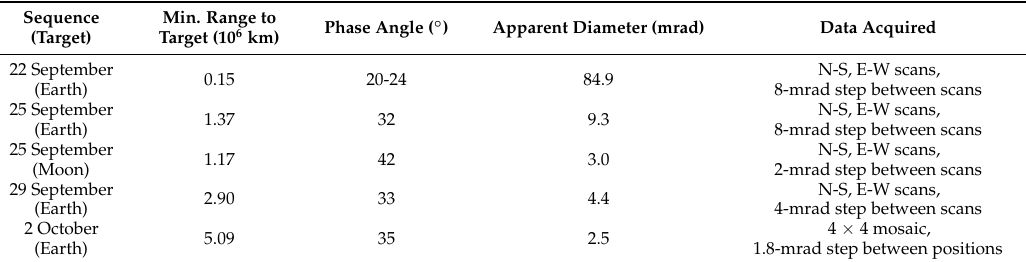
Table 1. Earth Gravity Assist (EGA) data.